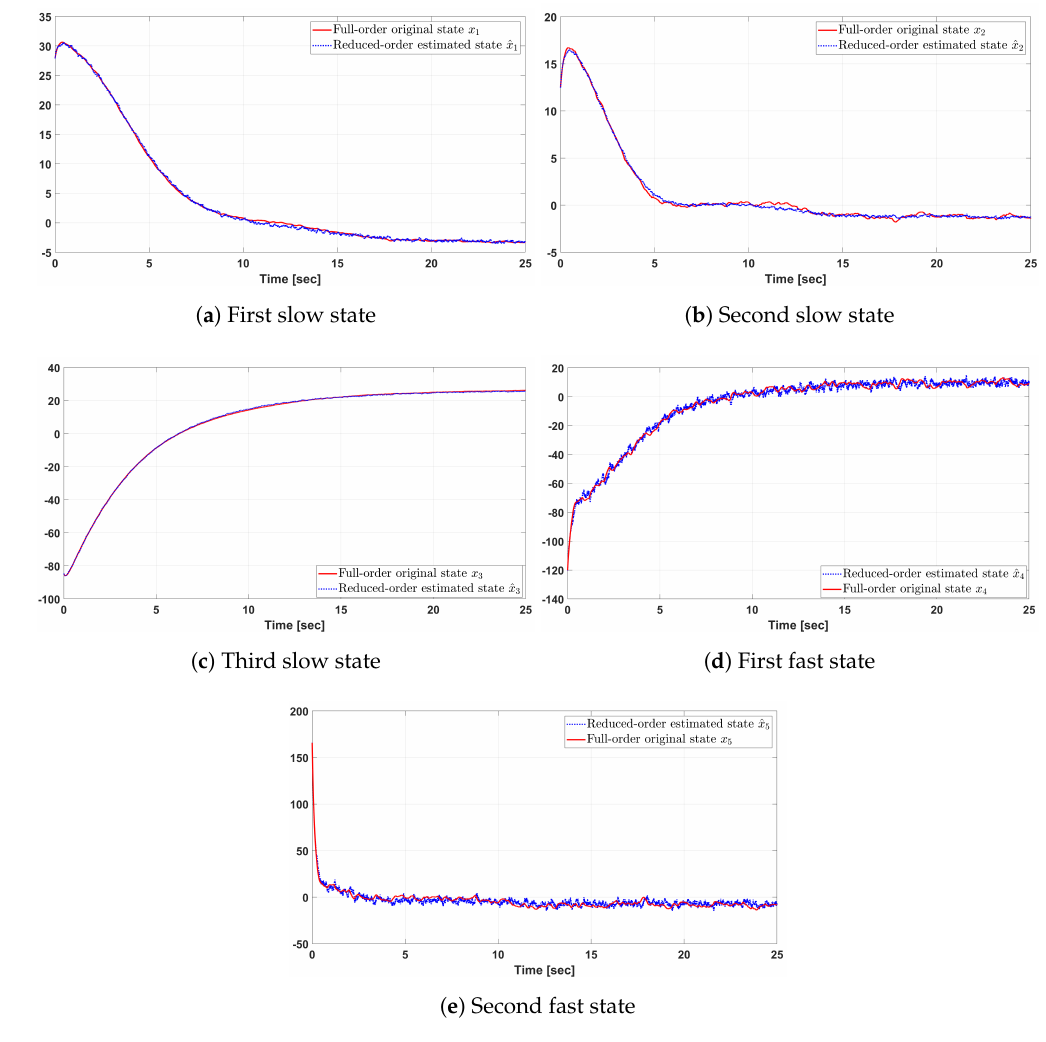
Figure 4. The original and reduced-order estimated states of the WT-DFIG.